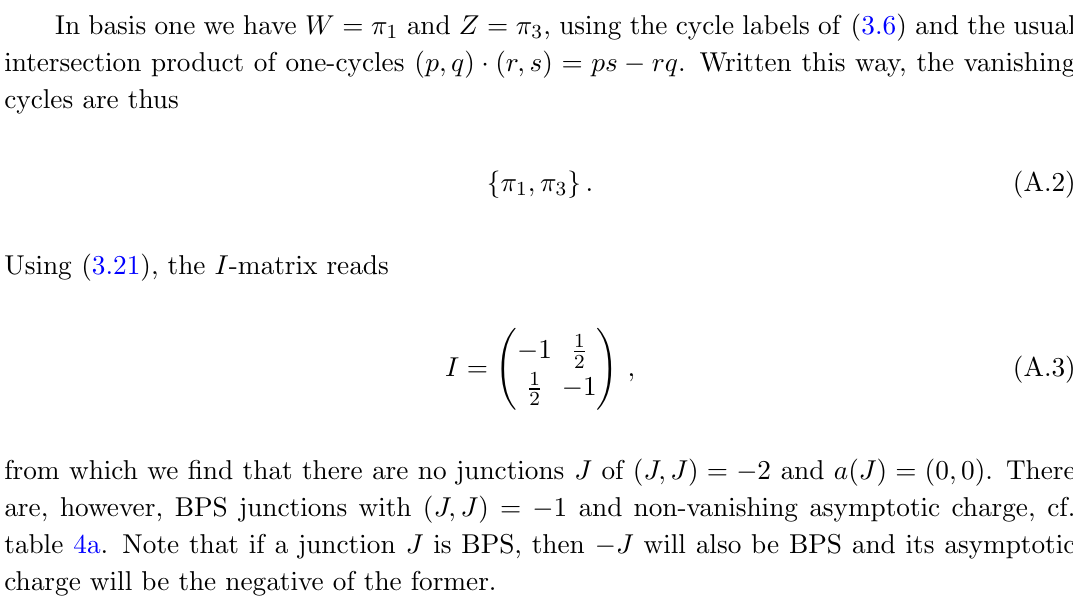
J will also be BPS and its asymptotic (cid:0)